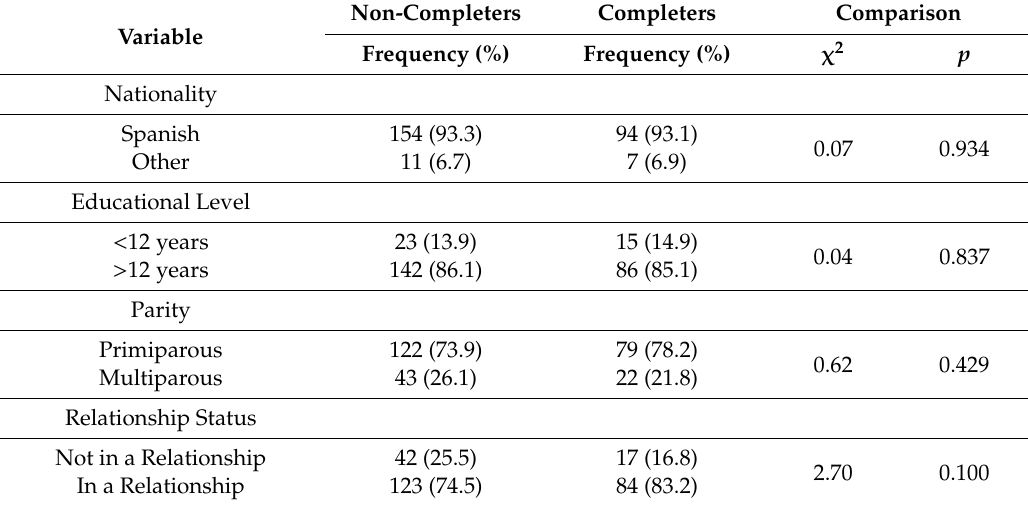
Table 3. Sociodemographic variables of the sample.